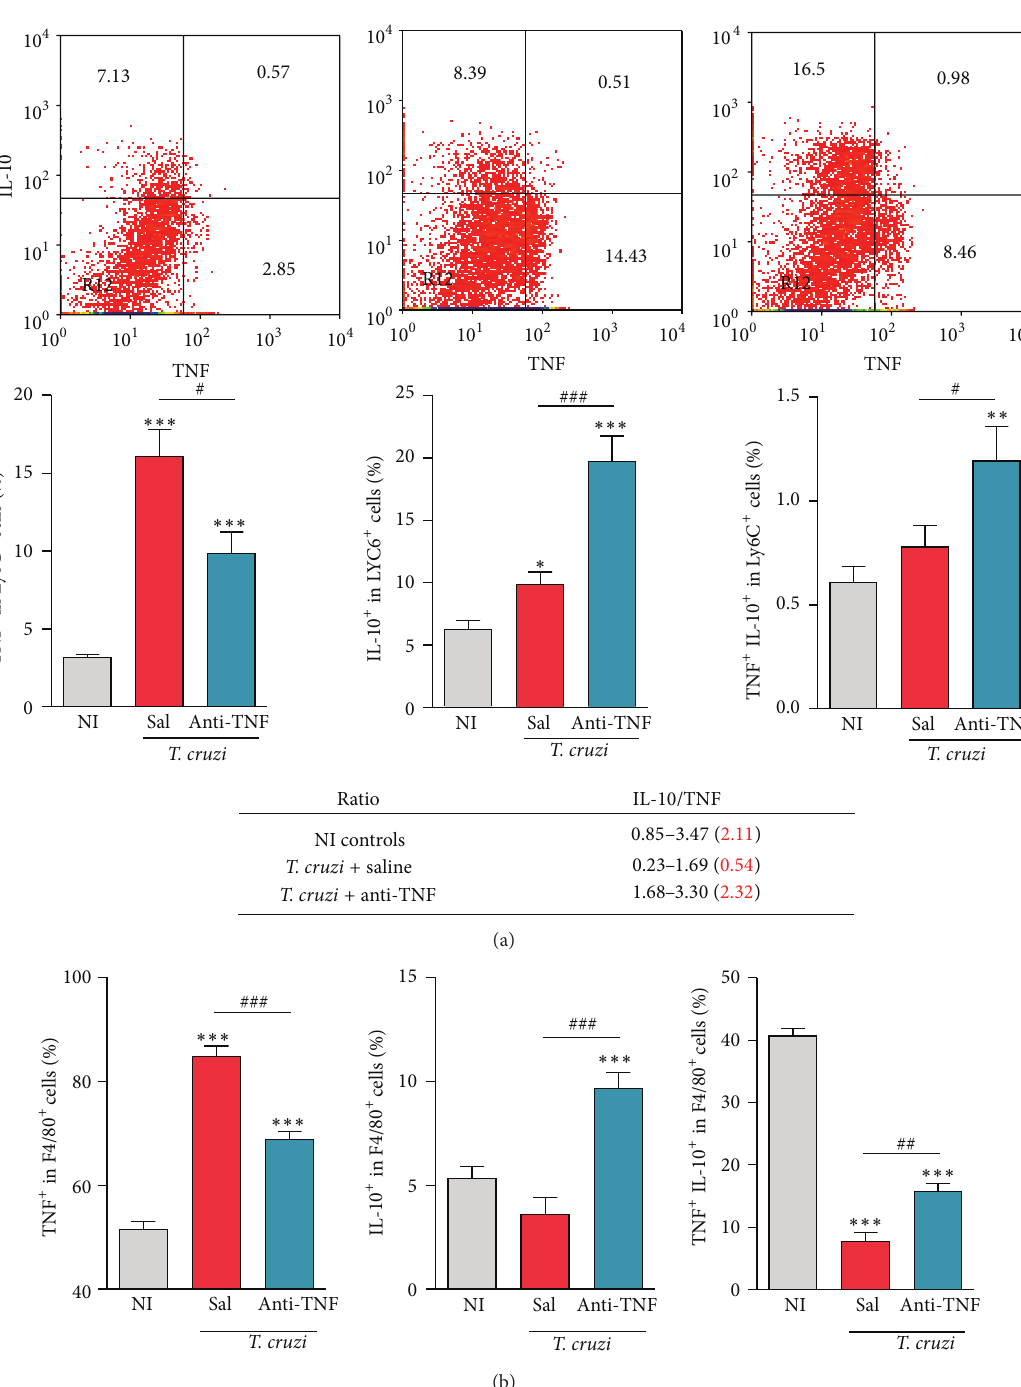
and F4/80 + macrophages in chronically Trypanosoma cruzi -infected mice. C57BL/6 mice infected with 100 bt of the Colombian T. cruzi strain were treated from 120 to 150 dpi and analyzed at 150dpi. (a) Representative dot plots, frequency of TNF + , IL-10 + , and TNF + IL-10 + cells among Ly6C + in the spleen [R1 (SSCxFSC) mononuclear cells gated], and ranges (means) of the IL-10/TNF relative ratios are shown. (b) Frequency of TNF + , IL-10 + , and TNF + IL-10 + double-positive cells among F4/80 + in the spleen [R1 (SSCxFSC) mononuclear cells gated]. ∗ 𝑃 < 0.05 , ∗∗ 𝑃 < 0.01 , and ∗∗∗ 𝑃 < 0.001 , T. cruzi -infected mice (saline injected or anti-TNF treated) compared to NI controls. # 𝑃 < 0.05 , ## 𝑃 < 0.01 , and ### 𝑃 < 0.001 , anti-TNF-treated compared to saline-injected T. cruzi -infected mice. Bar represents the mean ± SD of the studied group (4 to 6 mice). These data represent two independent